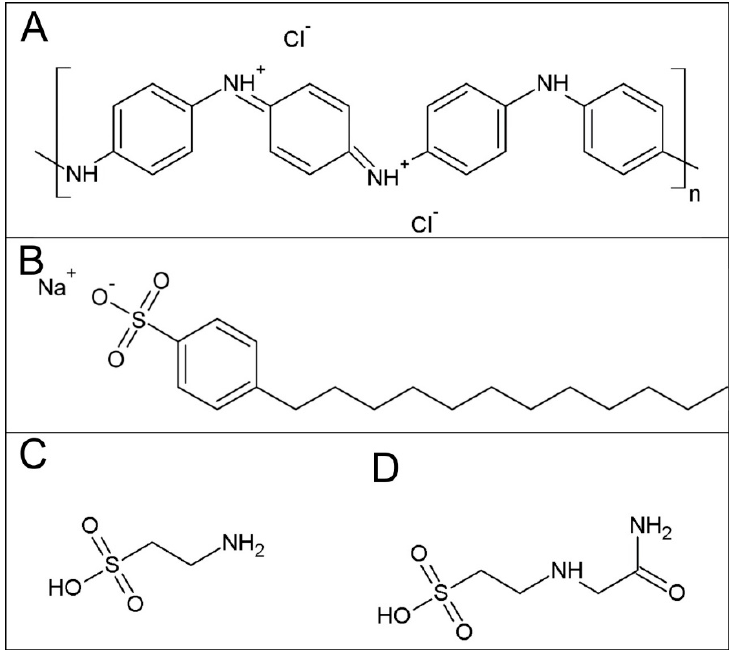
Figure 1. The formula of ( A ) PANI hydrochloride, ( B ) SDBS, ( C ), taurine, and ( D ) ACES.